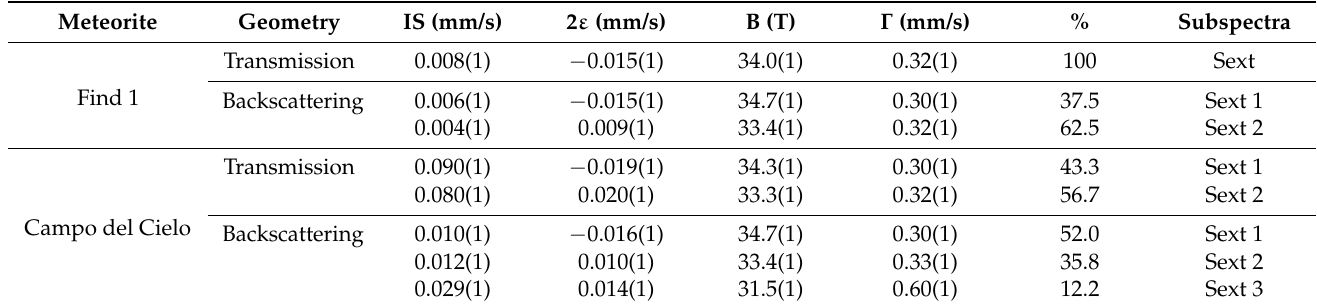
Table 2. Mössbauer parameters obtained from the fitting to the spectra shown in Figure 11 [31]. The errors in the last digit are given in